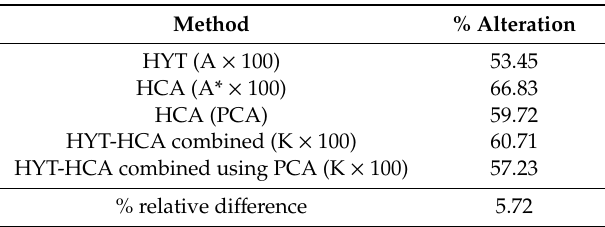
Table 9. Combined overall percentage alteration using HYT and